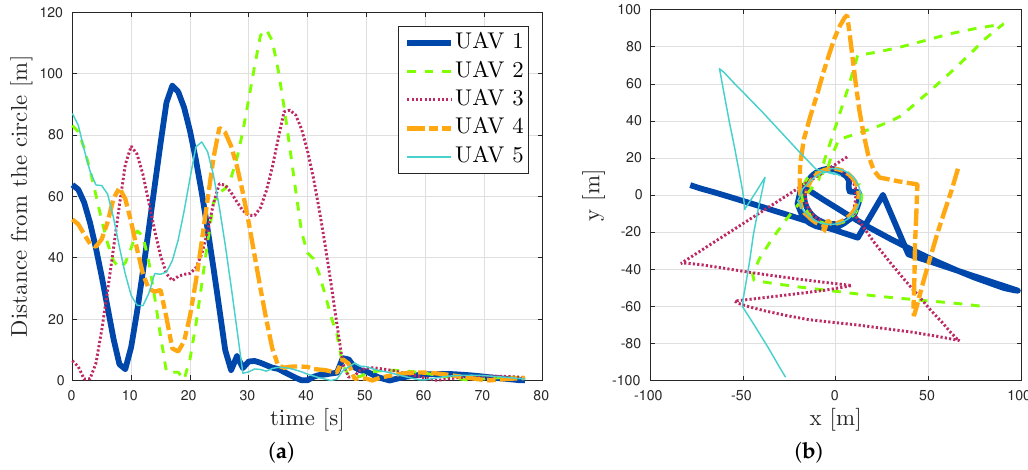
Figure 5. ( a ) Distance of the UAVs from the circle centred on the fixed target in position p ( t ) = [ 0,0 ] T . ( b ) Converging trajectories of the agents in the rendezvous with fixed target (the legend in (a)